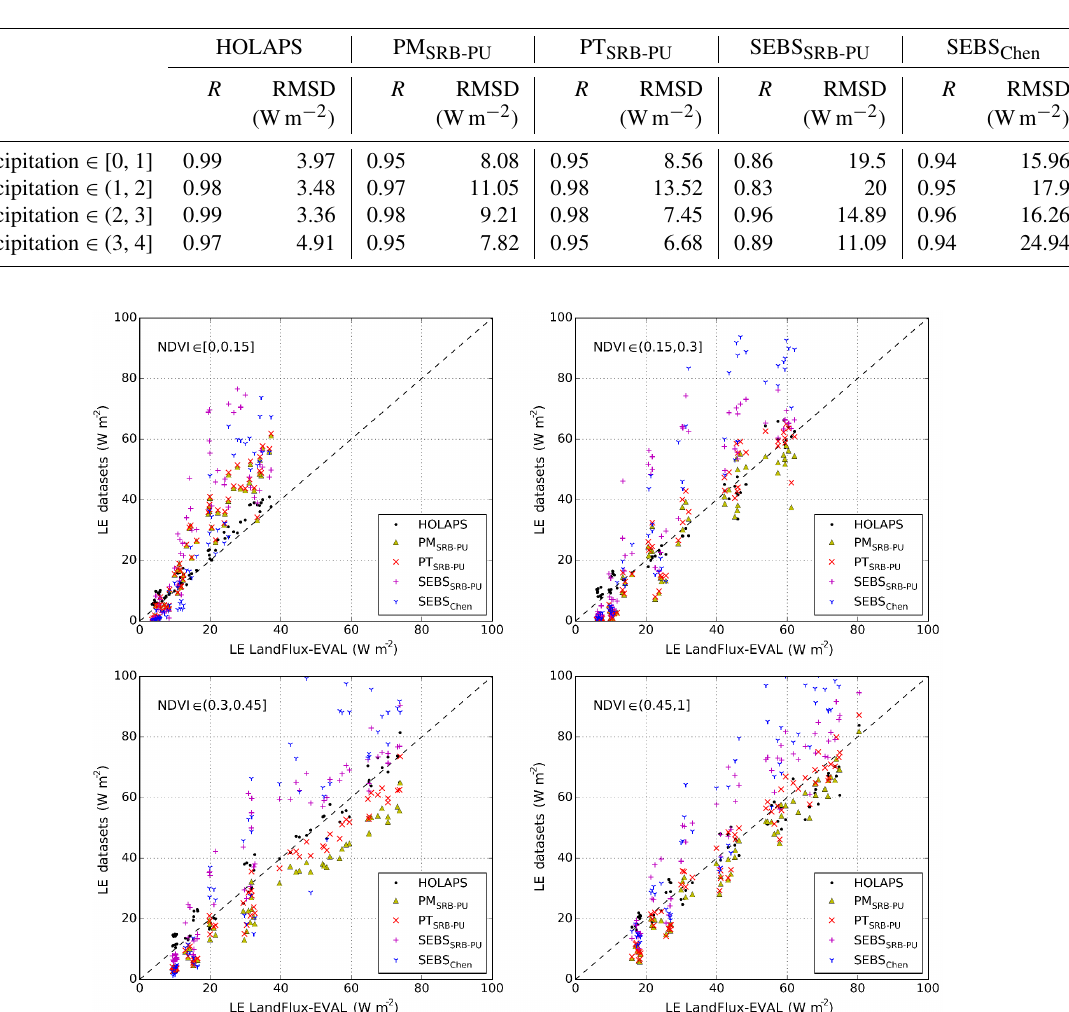
Figure 10. The monthly mean scatter plots of LE between the LandFlux-EVAL benchmark product and other products over different NDVI